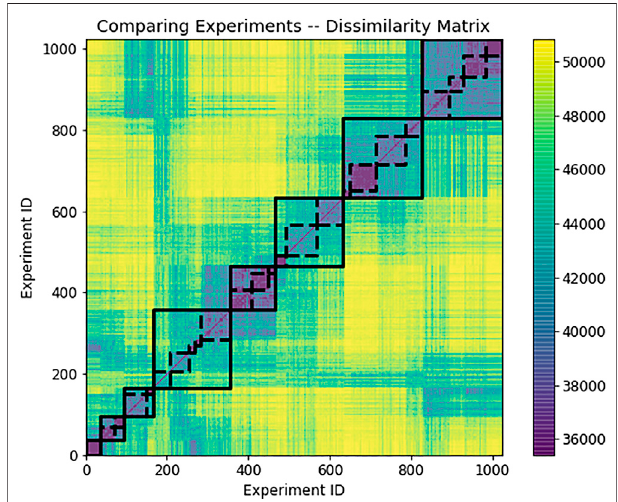
FIGURE 3 | There are M 2 (cid:2) 1024 forcing experiments in total, carried out on an N ≈ 10 6 -node system, with ( K , M ) (cid:2) ( 1024 , 32 ) , and average in and outdegree z (cid:2) Q / K ≈ 750,similar tothesimulations discussed in[7].This depicts the M 2 × M 2 pairwise dissimilarity matrix, with the experiments ordered appropriately, as well the discovered hierarchical partition into 8 and 24 modes that are shown in Figure 4 . (Note that the colours indicate the dissimilarity score, but the colour-bar istruncated at thevalues forthe 2.5 and 97.5% percentiles.)